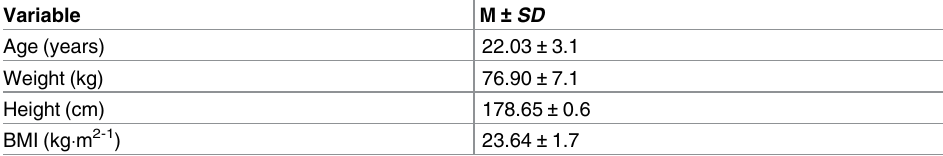
Table 1. Anthropometric characteristics of the 34 study